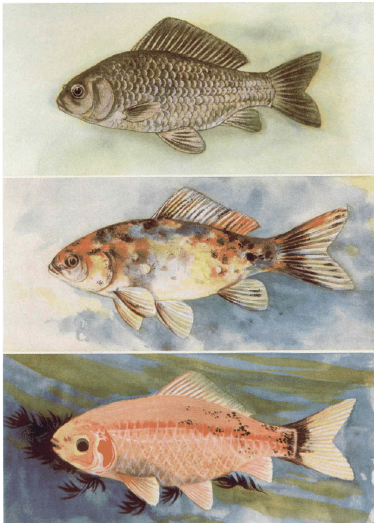
Figure 2. Gold fi sh by Shisan C. Chen (1928). From above: Normal scaled fi sh, Heterozygous mottled fi sh, Homozygous transparent fi